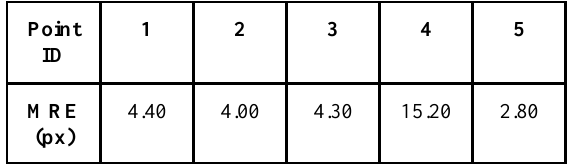
Table 1. Mean Reprojection Error computed for each GCP